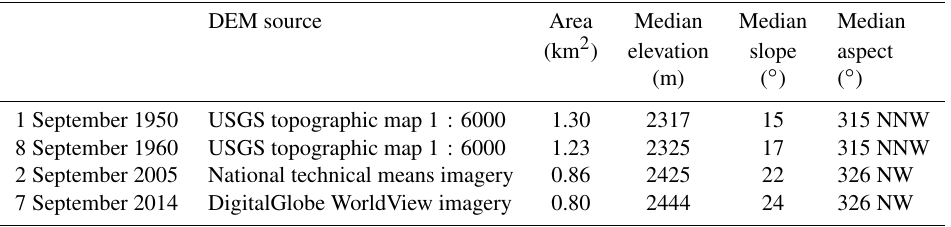
Table 2. Digital elevation model (DEM) specifications and glacier elevation results. Acquisition dates for the original imagery used to derive elevation data are